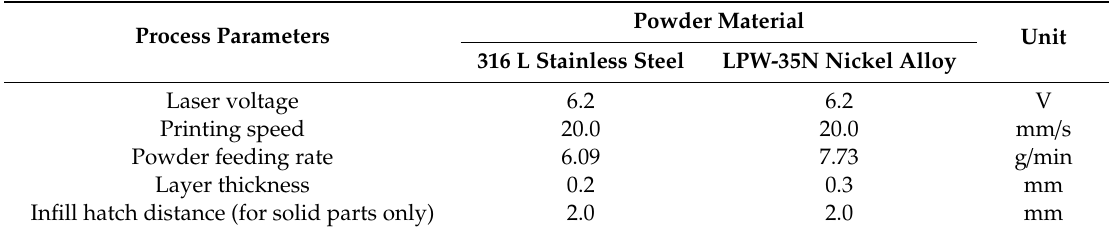
Table 2. Constant nominal process parameters used for direct energy deposition (DED) processes without